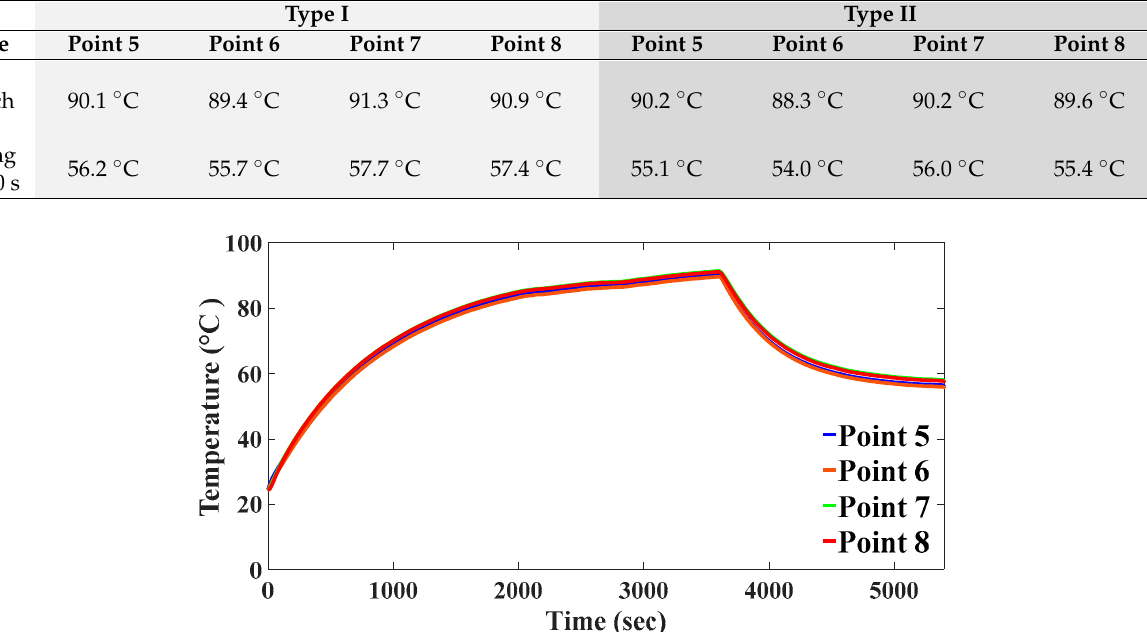
Figure 21. Temperature responses in Type II upper-plate point. Table 5. A comparison of heating source measurement.